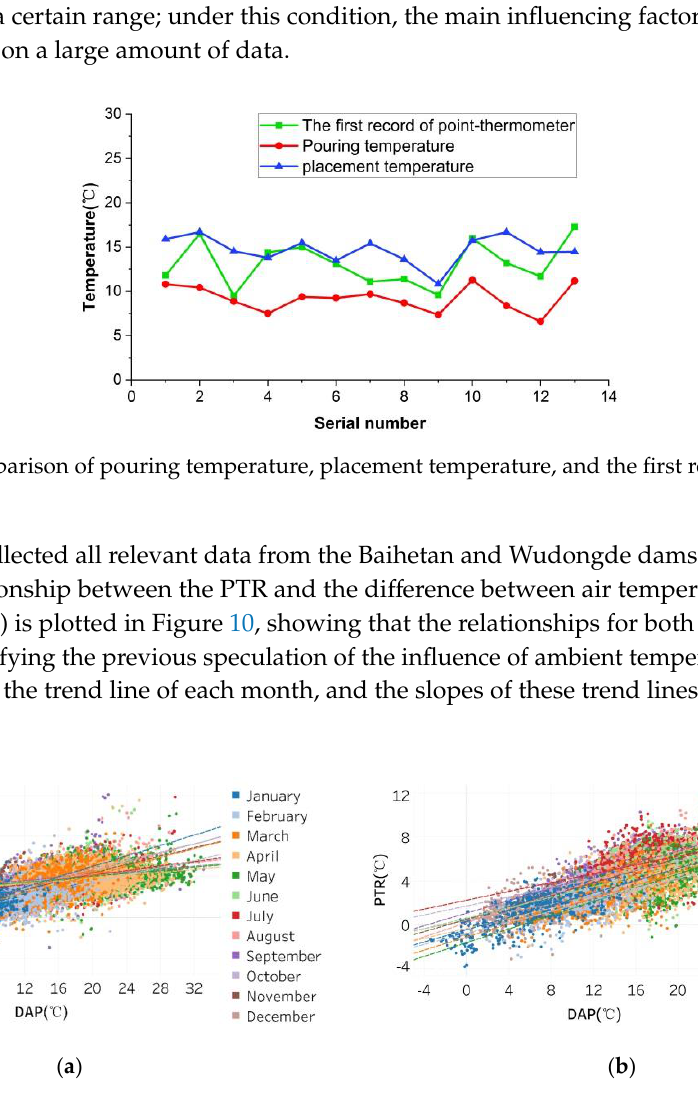
Figure 9. Comparison of pouring temperature, placement temperature, and the first records of point- thermometers.